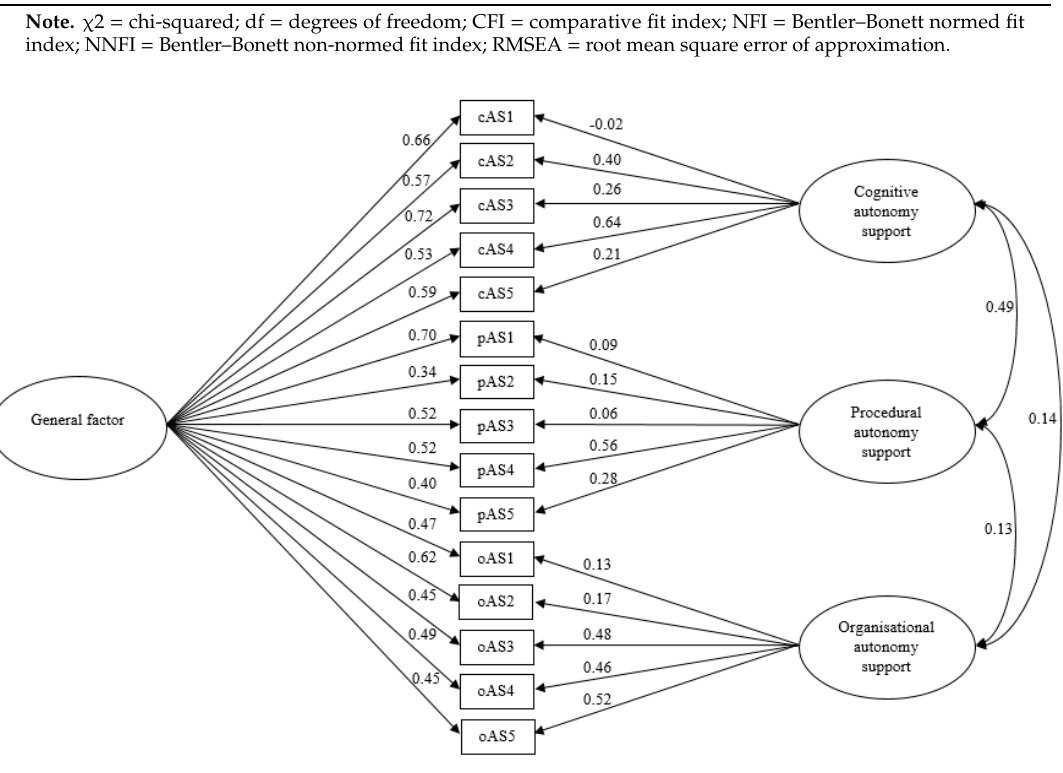
Figure 1. Bi-factor model of the German Multi-Dimensional Perceived Autonomy Support Scale for Physical Education (MD-PASS-PE). Standardized regression weights are presented next to the single-headed arrows, factor correlations are presented on the right of the double-headed arrows. Based on high modification indices, covariances were set between the error terms of items pAS3 and pAS5, and between the error terms of items oAS1 and oAS2.